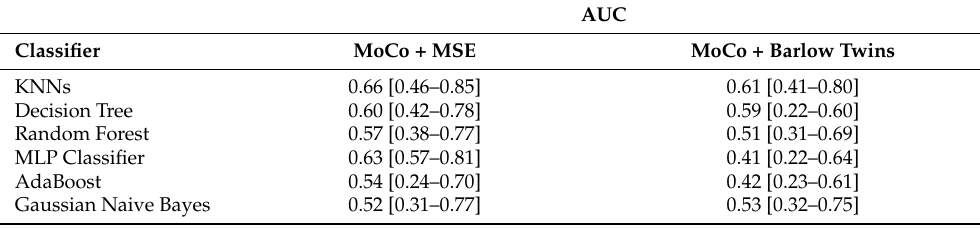
Table 6. Performance of models trained via self-supervised learning methods (MoCo + MSE and MoCo + BT) for stroke vs. control classification task after fine-tuning on different classifiers. Age- stroke-controlled cohort is